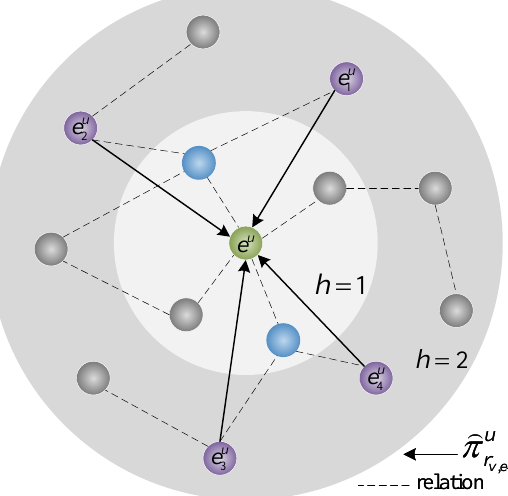
Figure 4. A two-layer perception depth of item entity in a